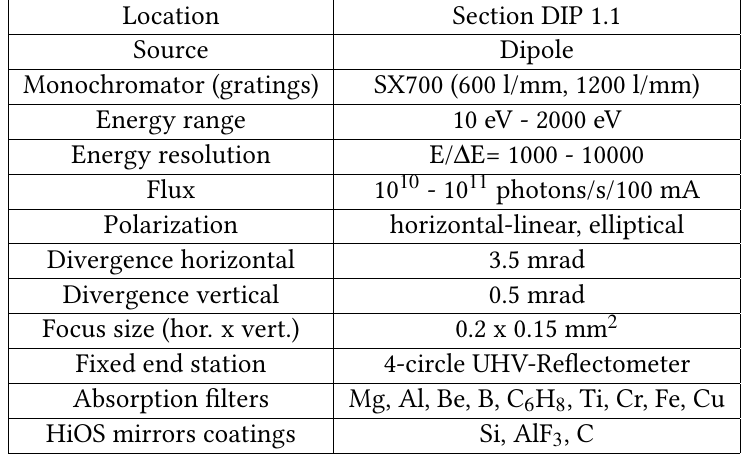
Table 2: Performance data of Optics Beamline